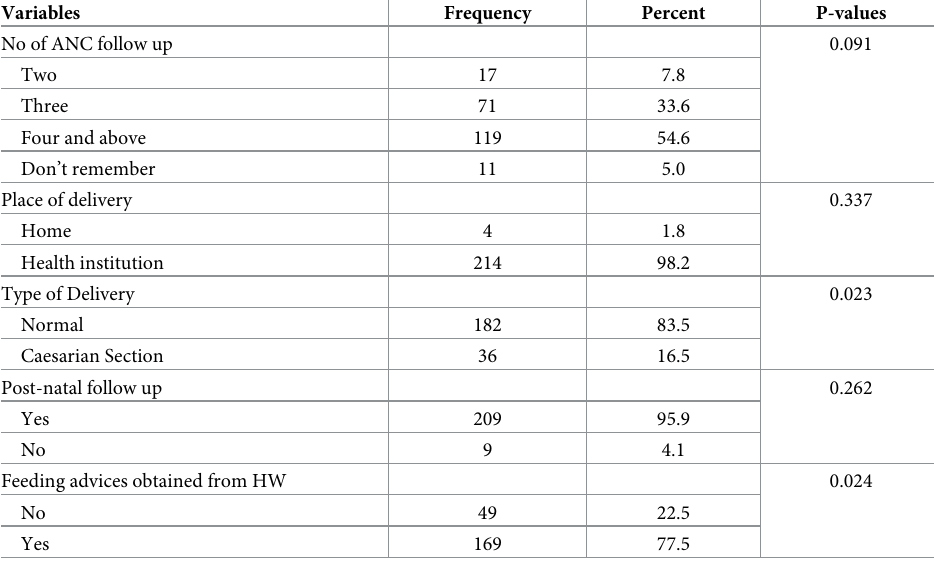
Table 2. Obstetric history of study participants (n = 218) West, East and Kellem Wollega Districts health institu- tions western Ethiopia, September 2017 to June 30, 2018.